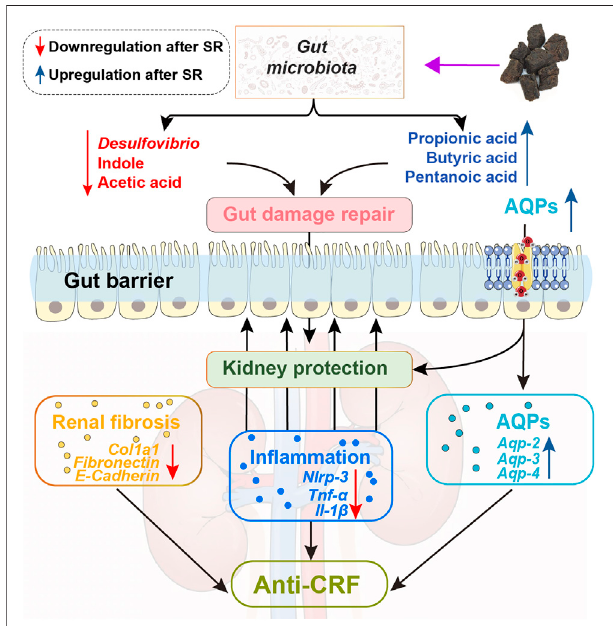
FIGURE 9 | Schematic diagram showing how SR decoction improved CRF. Red arrows, decreased changes after SR decoction treatment. Blue arrows, increased changes after SR decoction